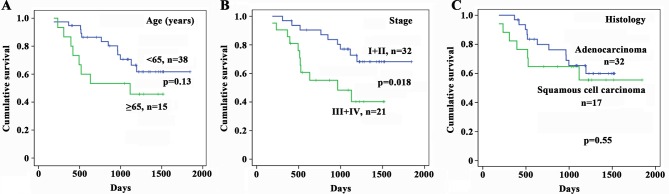
Kaplan–Meier estimates of survival of patients with non-small cell lung cancer (NSCLC) according to age, cancer stage, and histology.